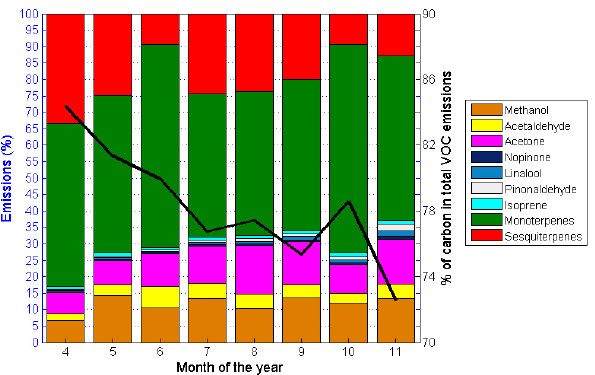
Figure 4. Normalized contribution of each VOC measured com- pared to the total sum of emission rates (left axis) along with the percentage of carbon in the total VOC emissions (right axis) for each